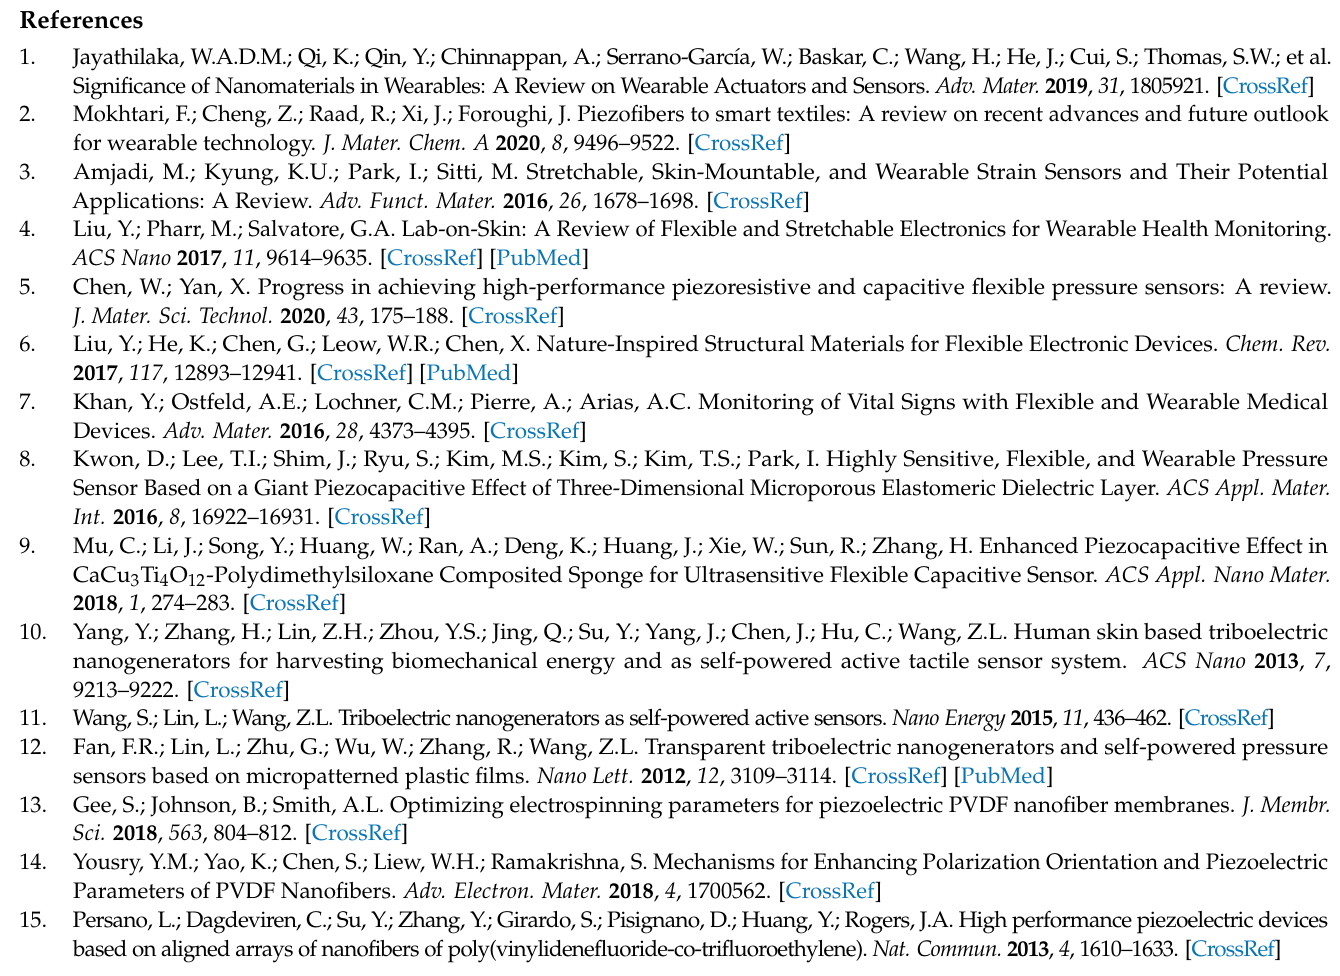
V ES =9.0 kV and different t dep . (a) t dep = 0.5, 1, 1.5, 2, and 3 min and (b) t dep = 4, 5, 6, 7, 9, 11, and 14 min.; Figure S9: Strain–pressure characteristics of the fiber mats produced with V ES =11.0 kV